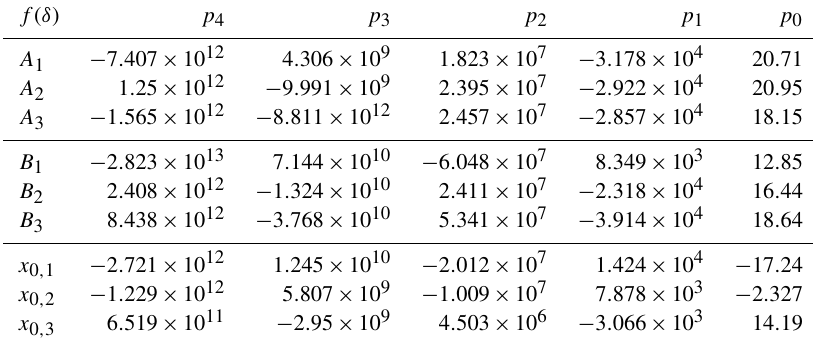
Table A1. Parameters p k for semiaxes and center